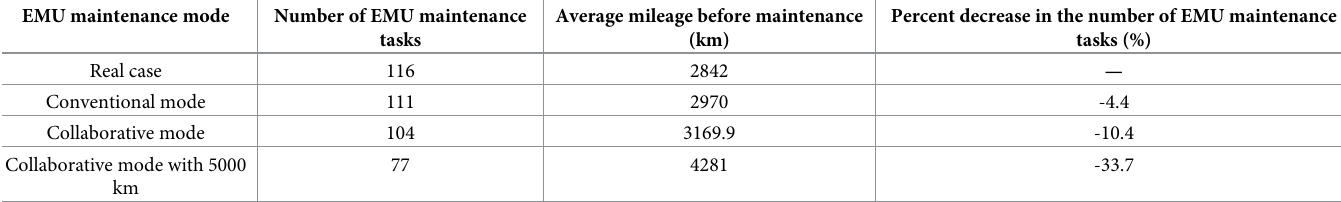
Table 12. Number of EMU maintenance tasks in each EMU maintenance